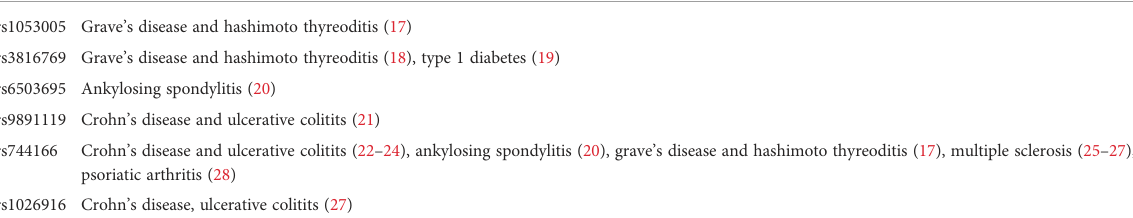
TABLE 1 Selected single nucleotide polymorphisms in STAT3 associated with common autoimmune diseases.